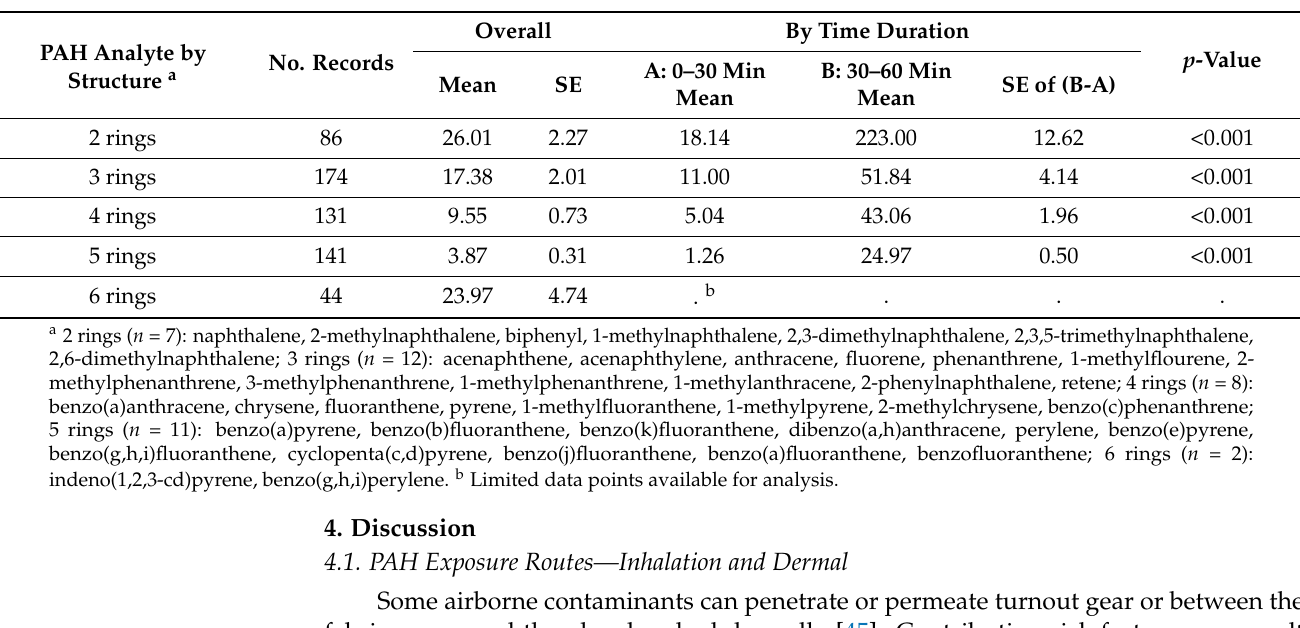
Table 5. Collection time and PAH (AM) from personal air samples by structure groups (unit: µ g/m 3 ). Bold p -values indicate statistically significant increases in PAH concentrations with